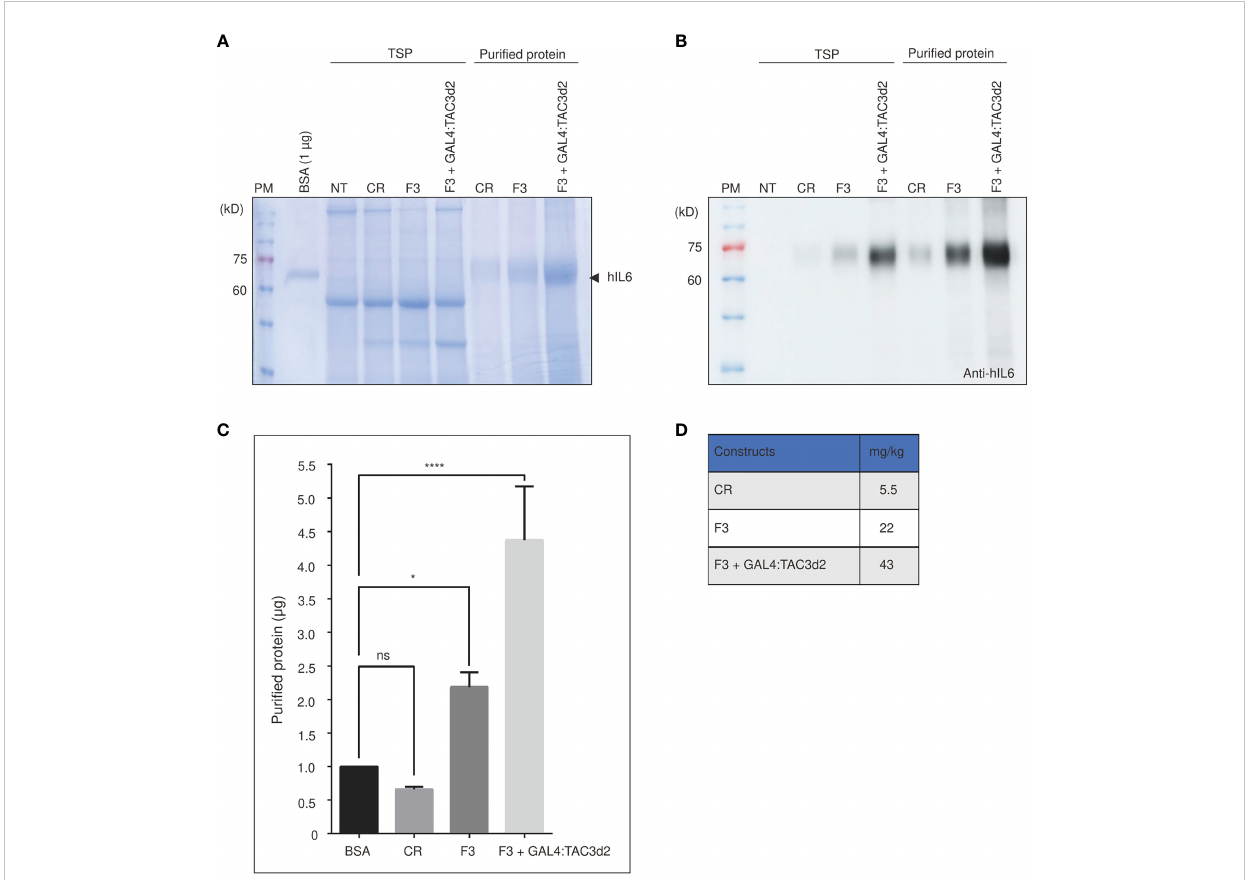
FIGURE 7 Protein puri fi cation con fi rms the composite terminator strongly enhances protein expression with FM ’ M-UD promoter and arti fi cial transactivator GAL4/TAC3d2. (A, B) Analysis of puri fi ed report proteins. The reporter protein was puri fi ed using MCC beads from total soluble protein extracted from 100 mg leaf tissues and analyzed by SDS/PAGE followed by CBB staining (A) or western blotting using anti-hIL6 antibody (B) . NT: wild-type plant without in fi ltration. CR: CaMV 35S promoter plus RD29Bt; F3: FM ′ M-UD promoter plus 3PRt; GAL4/TAC3d2: Transactivator consisting of GAL4 DNA binding domain plus TAC3d2 activation domain. Arrow indicates puri fi ed BMCS:hIL6. (C, D) Quanti fi cation of puri fi ed proteins. The intensities of CBB-stained protein bands were measured using the LAS-3000 imaging system and converted to µg based on the intensity of 1 µg BSA. The yield was calculated based on the yield in (C) and is presented in mg/kg fresh weight (FW) (D) . Three independent experiments were carried out to quantify the production yield. The data shown are means ± SE (n = 3); asterisks indicate statistically signi fi cant differences determined using one-way ANOVA followed by Dunnett ’ s multiple comparison test; ns: no signi fi cant difference; *: P < 0.05; ****: P <